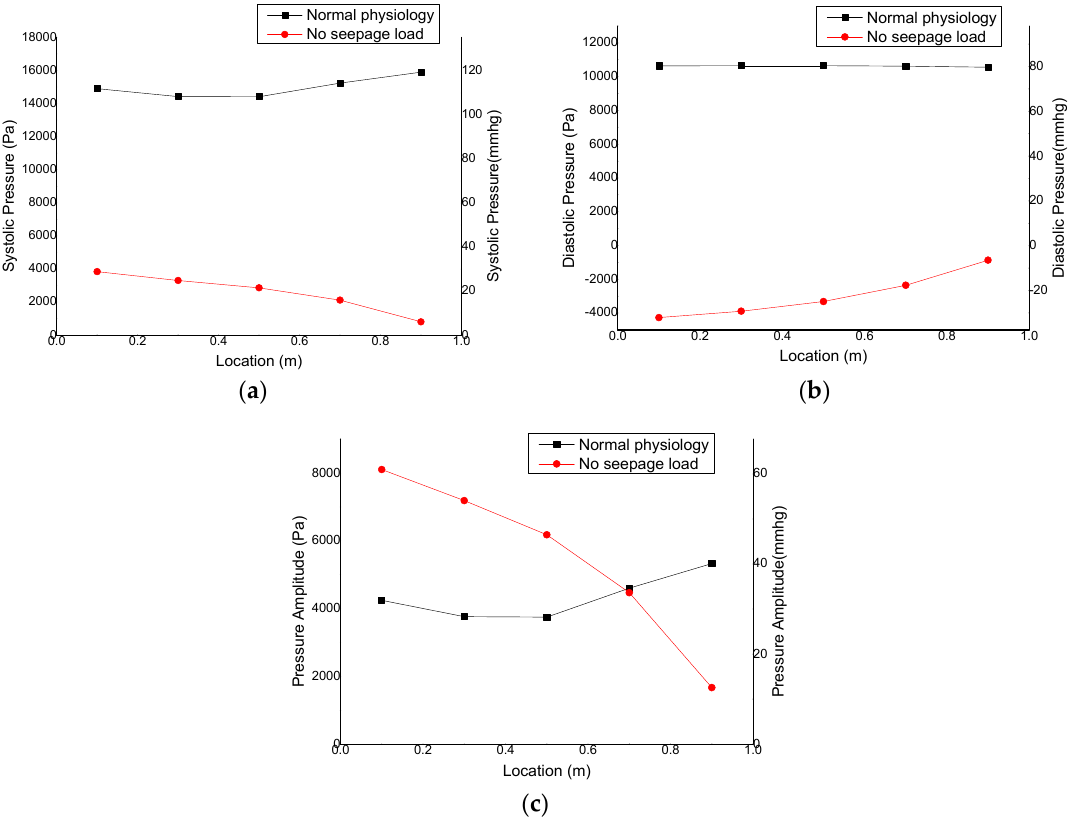
Figure 5. Comparisons of pressure in the examples with seepage load and pressure-free outlet: ( a ) maximum vascular pressure; ( b ) minimum vascular pressure; ( c ) pressure amplitude.